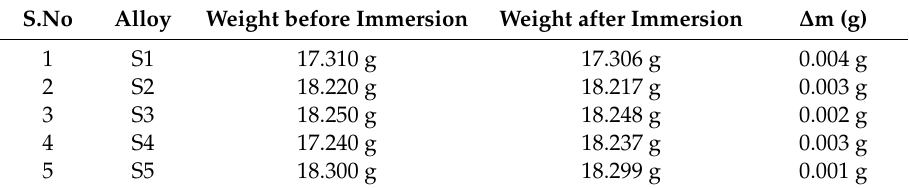
Table 4. Weight loss measurements for all samples in artificial saliva solution.